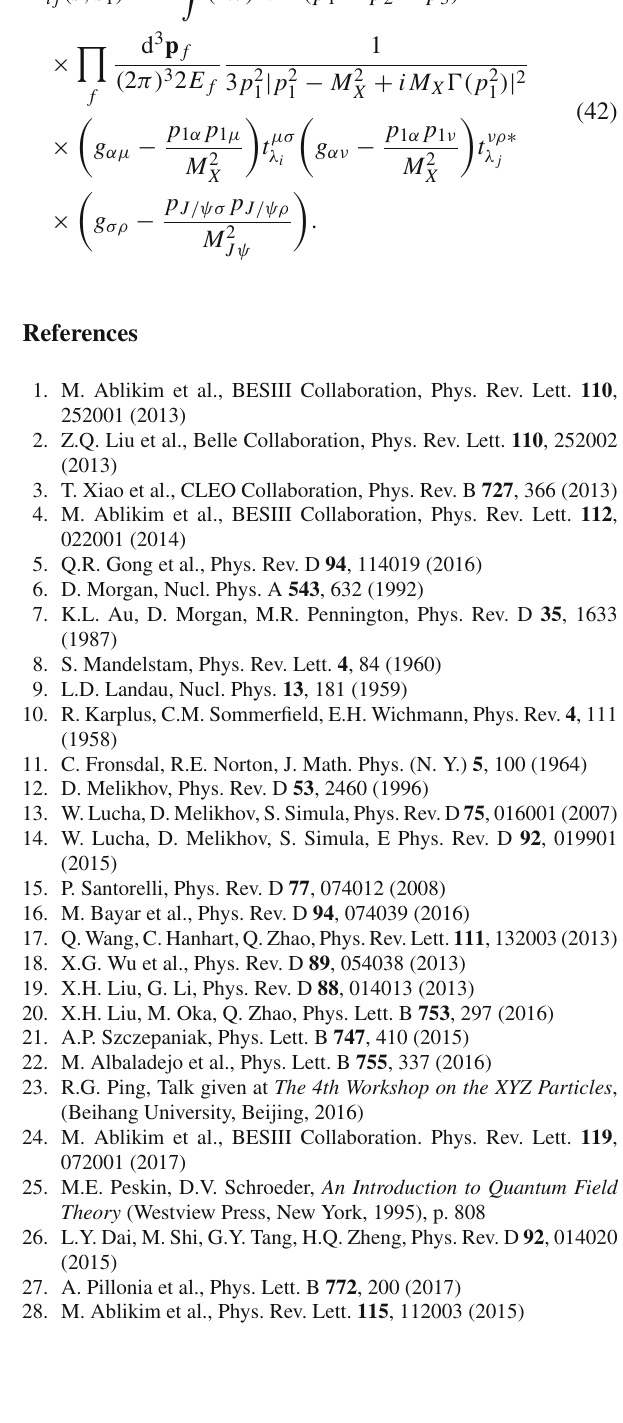
Fig. 11 The process of e + e − → J /ψππ( D ¯ D ∗ π)